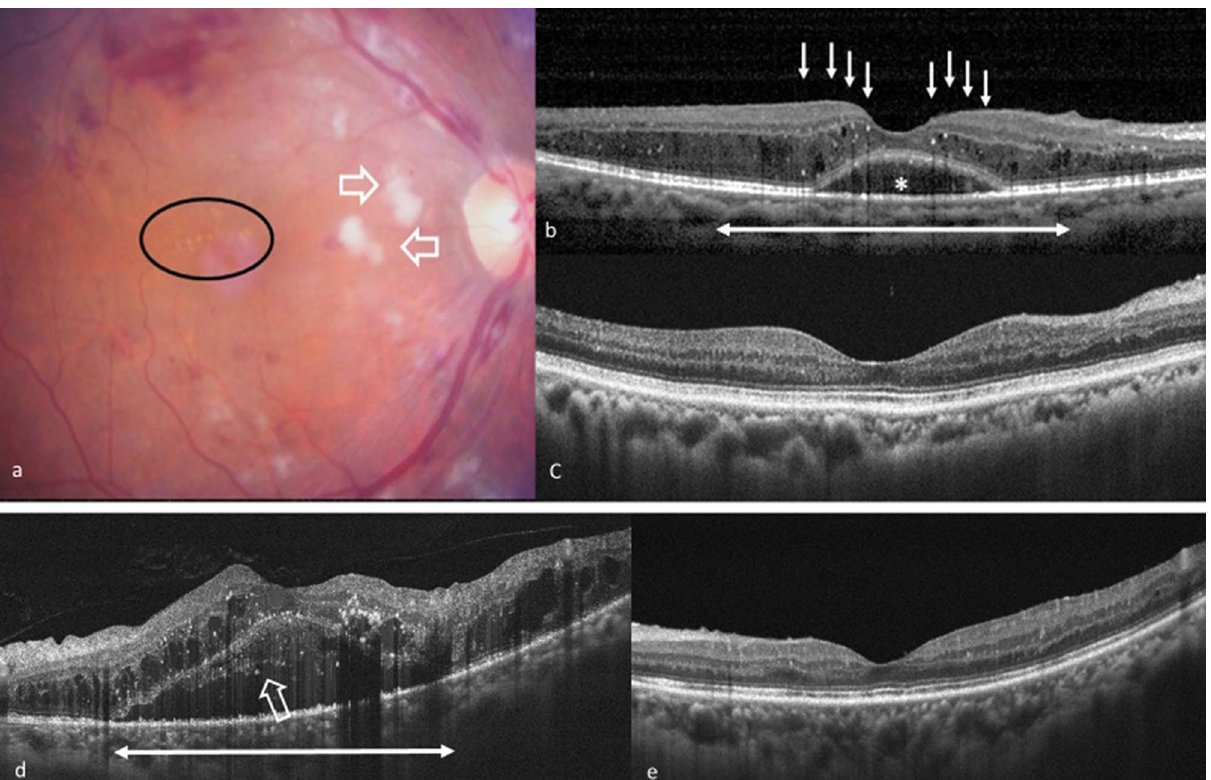
Figure 3. Two representative cases of patients who had DME and underwent anti-vascular endothelial growth factor treatment. ( a – c ) A 67-year-old female patient without previous treatment for DME. ( a ) The fundus photography at the baseline revealed severe non-proliferative diabetic retinopathy with diffuse retinal haemorrhage and cotton wool spots (empty arrows). There was a limited amount of hard exudate in the macular area (circle). ( b ) The OCT at baseline exhibited DME and the presence of SRF (asterisk). Large numbers of HRF, mostly located in the outer retina (white arrows), were found within 3 mm of the central macula (double arrow). The baseline visual acuity was 20/100, and CFT was 406 μm. ( c ) The patient received three injections in 1 year, and the final OCT revealed total resolution of DME and disappearance of HRF in every retinal layer in the central macula. The visual acuity was 20/30, and the CFT was 188 μm at the final visit. ( d , e ) A 49-year- old male patient without previous treatment for DME. ( d ) The OCT at baseline exhibited DME with SRF and the presence of HRF in all three retinal layers. The presence of HRF in SRF is highlighted (empty arrow). The baseline visual acuity was 20/100, and the CFT was 859 μm. ( e ) After eight injections in 1 year, the final OCT revealed total resolution of DME and significantly decreased HRF in every retinal layer. The visual acuity was 20/25, and the CFT was 213 μm at the final visit. CFT central foveal thickness, DME diabetic macular oedema, HRF hyperreflective foci, OCT optical coherence tomography, SRF subretinal